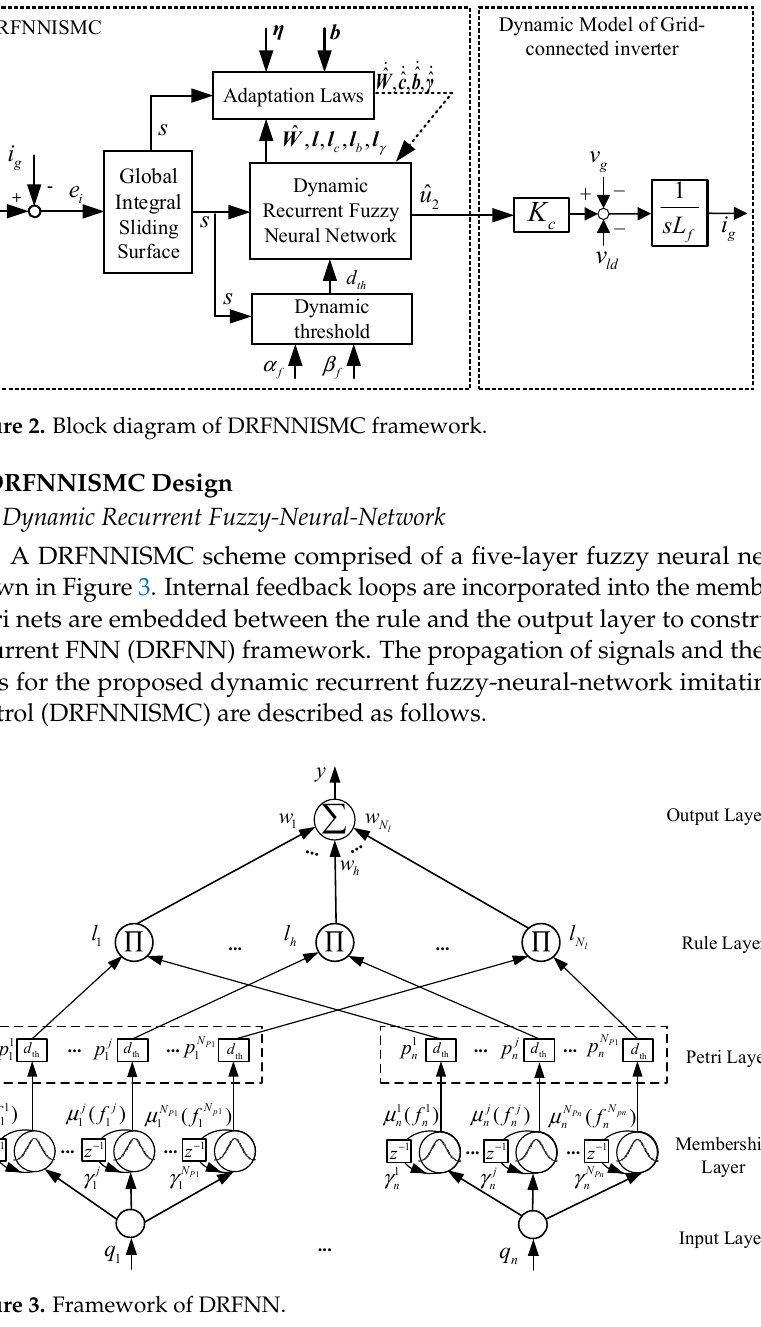
Figure 3. Framework of DRFNN.